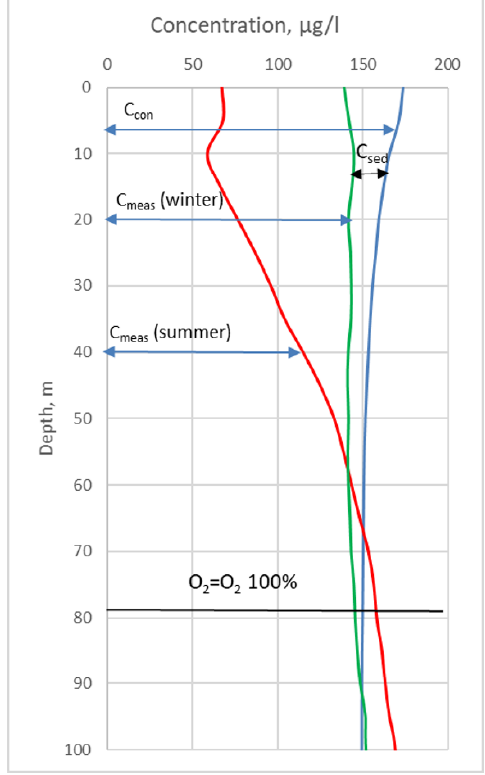
Figure 2. An example of the vertical distribution of nitrogen – nitrate concentrations in one of the regions of the Barents Sea. The red line is the winter distribution of nitrogen – nitrate C meas (winter); the green line is the summer distribution C meas (summer); the blue line is the summer conservative concentration; the black line is the horizon at which the saturation of water with dissolved oxygen in the summer decreases to less than 100%.